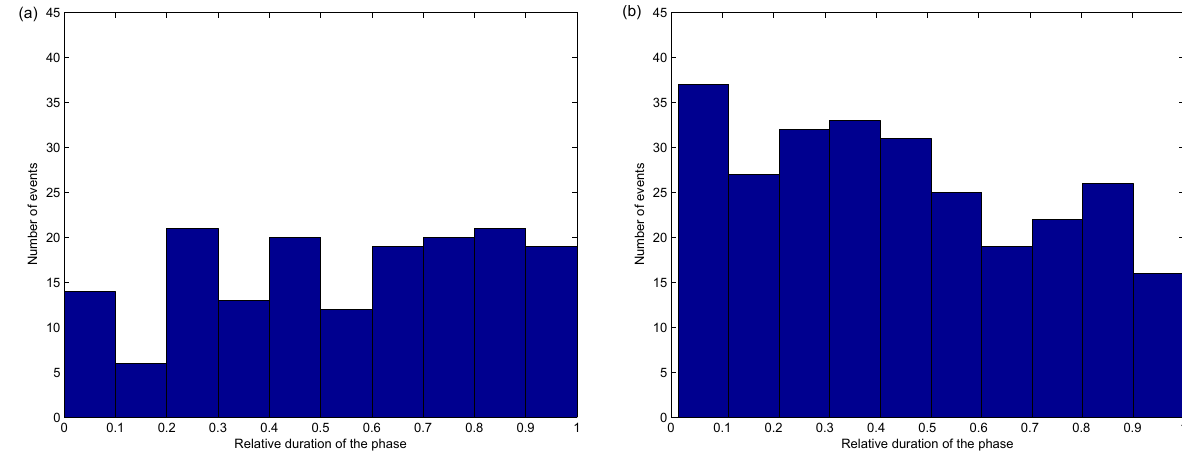
Figure 4. Occurrence of omega-like structures with respect to the relative duration of the substorm expansion (a) and recovery (b) phases. The substorm phases are automatically detected in the local electrojet index data IL ASC . The total of 165 omegas was found within expansion and 274 of them within the recovery